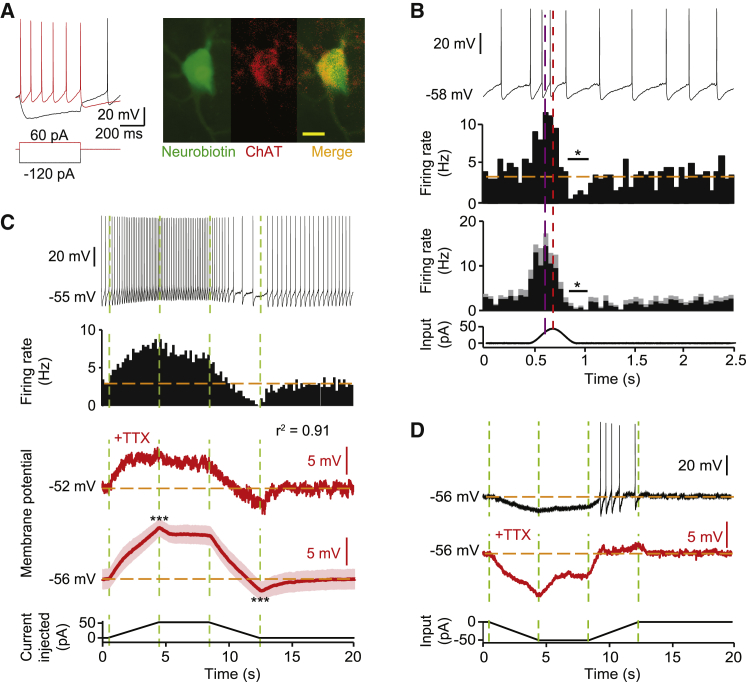
ChI Firing Ex Vivo Rate Reflects Changes to Excitatory Input and Pauses Are Driven by Withdrawal of Excitation(A) Characteristic ChI physiology. Immunocytochemical co-labeling: neurobiotin fill; ChAT-immunoreactivity (scale bar, 20 μm).(B) Example sweep, example firing rate histogram (20 sweeps), and mean firing rate histogram ± SEM (n = 6) of ChI response to a sine-wave current. Highest firing rate (purple dashed line), input current maximum (red dashed line), reduced firing rate versus baseline, ∗p < 0.05, t test.(C and D) Responses to trapezoid current injections for depolarizing (C) and hyperpolarizing (D) input. (C) Top to bottom: example sweep, example firing rate histogram (20 sweeps), and representative and mean membrane potential ± SEM in presence of TTX 1 μM (red). Correlation, firing rate and membrane potential, r2 = 0.91, 100 bins. ∗∗∗p < 0.001, paired t tests for maximum versus plateau and minimum versus baseline (n = 10). (D) Example sweep plus membrane potential in presence of TTX (red).